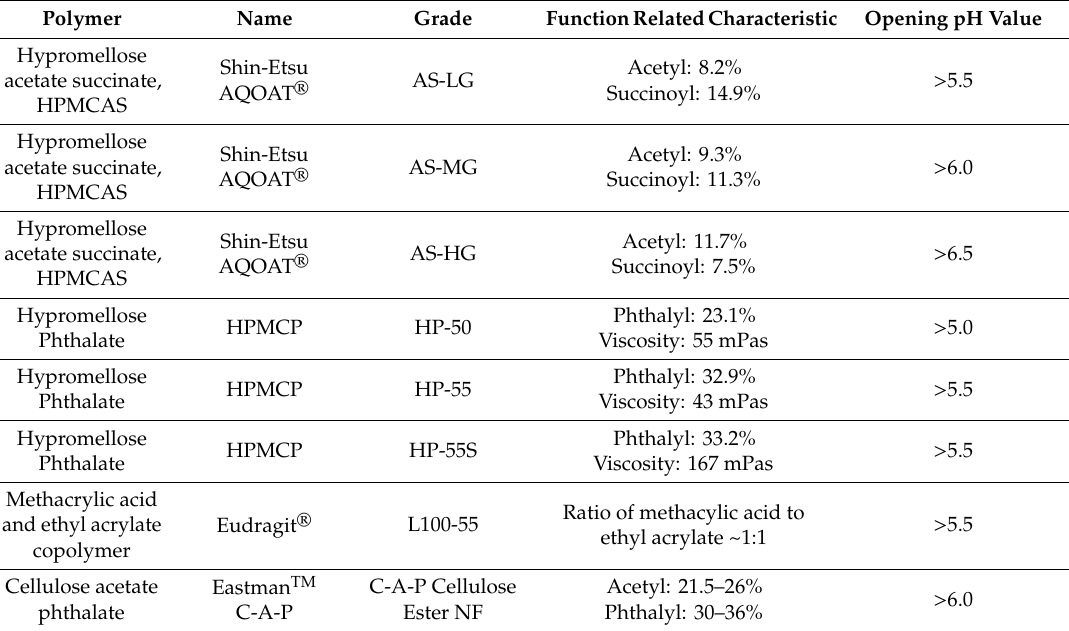
Table 1. Polymers used in the present